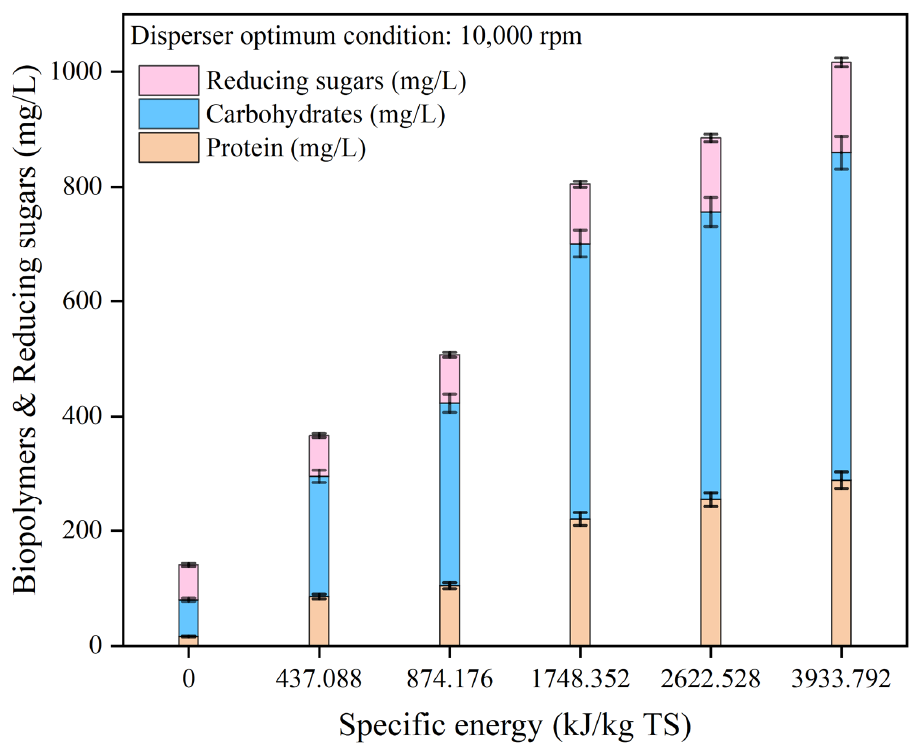
Figure 4. Effect of specific energy on release of protein, carbohydrates, and reducing